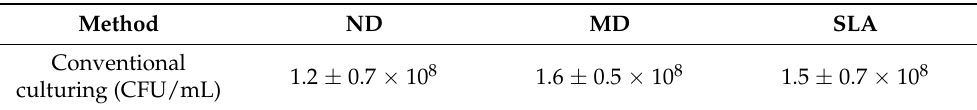
Table 2. Table representing mean CFU/disc following P. gingivalis exposure for possible bacterial adhesion on ND, MD, and SLA, for five replicates. ND showed a reduction of 17% and 20% com- pared to MD and SLA, respectively.